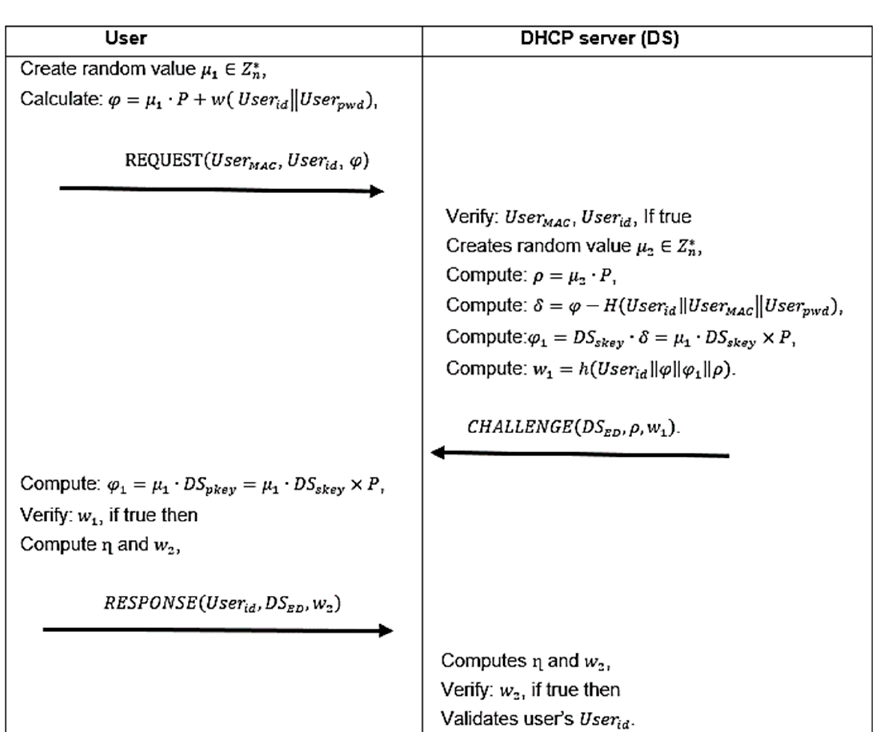
Figure 3. IPChain validation stage.